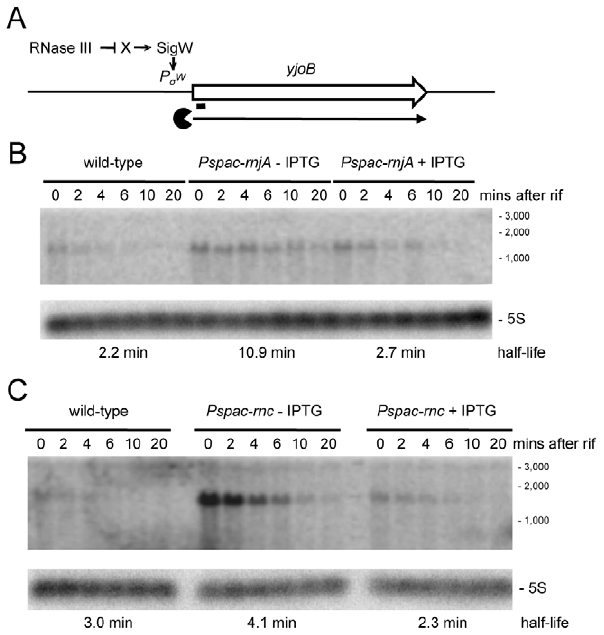
Figure 6. Degradation of the yjoB mRNA depends on RNase J1 while its transcription is dependent on RNase III. (A) Structure and predicted degradation pathway of the yjoB transcript. The ORF is shown as a large white arrow, transcript as a thin black arrow. The ‘Pacman’ symbol represent 5 9 -3 9 degradation by RNase J1. A short thick line indicates the position of the probe used. P s W indicates the approximate promoter position and relevant sigma factor mapped in [31,32]. The schematic also depicts RNase III initiated degradation of a transcript encoding an unknown factor X early in the SigW cascade. (B) Northern blot of total mRNA isolated at times after addition of rifampicin (rif) from wild-type and RNase J1 depleted ( Pspac-rnjA 2 IPTG) and RNase J1 induced ( Pspac-rnjA + IPTG) cells. The blot was probed with 5 9 -labeled oligo CCB807 (Table S6) and reprobed with oligo HP246 against 5S rRNA. The half-life of the yjoB transcript is given under the Northern blot. Migration positions of RNA markers are shown to the right of the blot. (C) Northern blot of total mRNA isolated at times after addition of rifampicin (rif) from wild-type and RNase III depleted ( Pspac-rnc 2 IPTG) and RNase III induced ( Pspac-rnc + IPTG) cells. Description as in panel